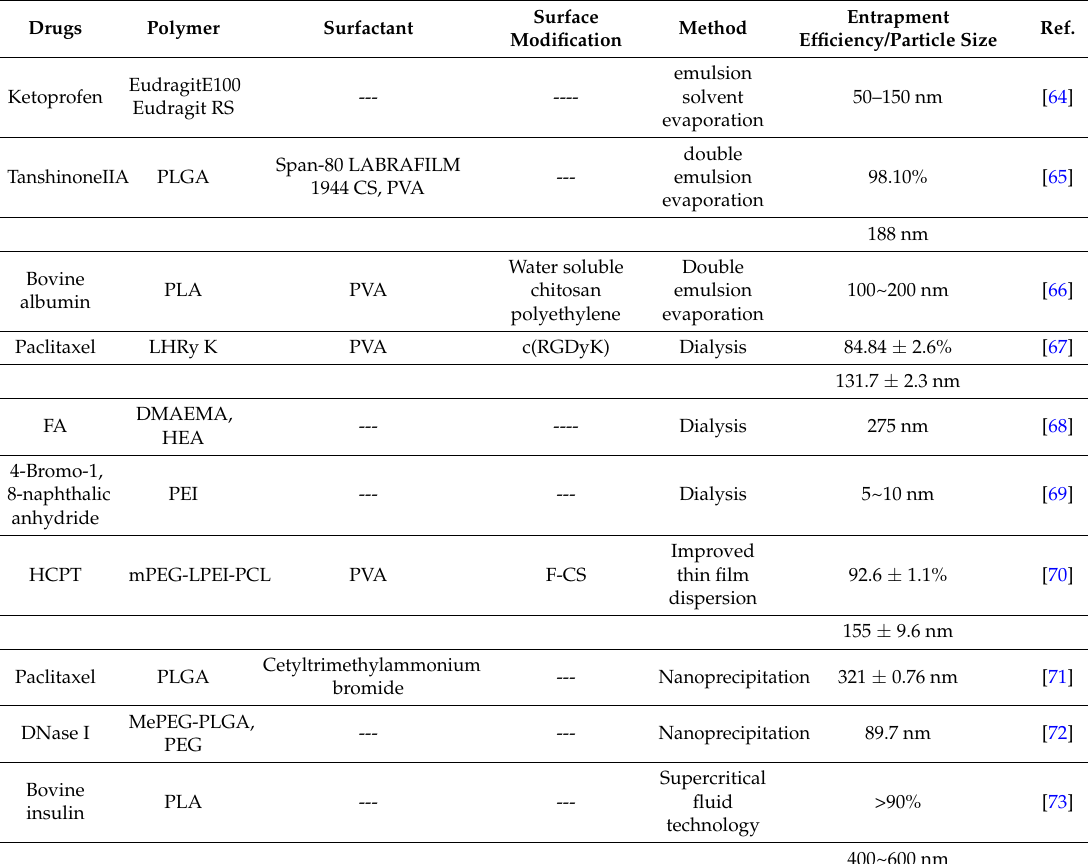
Table 2. Summary of methods for preparing